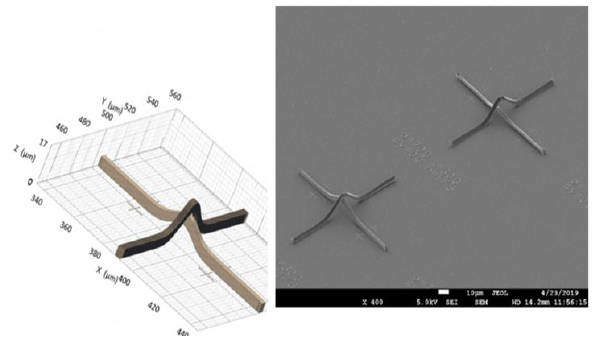
Fig. 1 . SEM image of PWB (photon connectors) and PWB